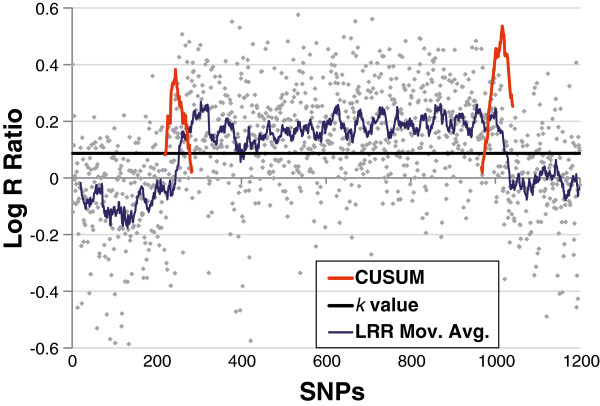
CUSUM-based boundary refinement. This figure illustrates the CUSUM-based approach to boundary refinement applied to the LRR values in a large amplification event. The two peaks of the CUSUM plots denote the change-points (boundaries) of the region. The optimized k value allows for similar slopes on either side of the detected boundaries (max Sn).